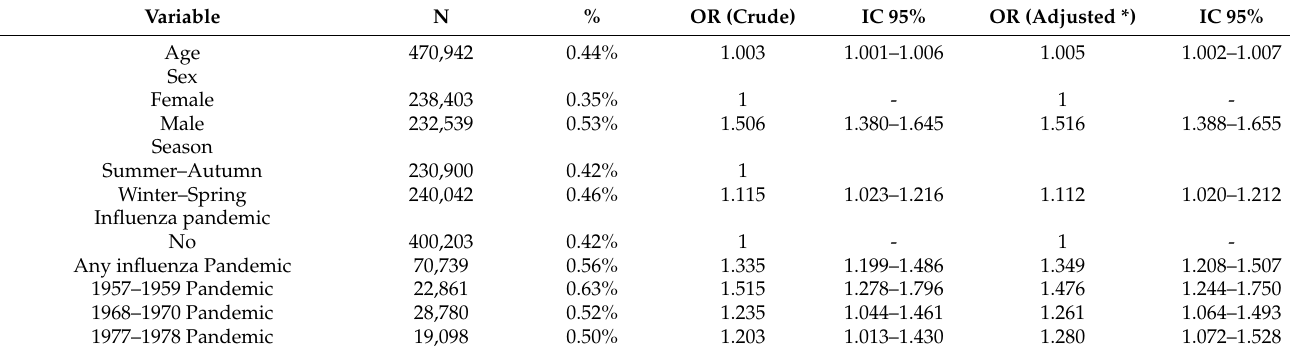
Table 3. Prevalence odds ratio of schizophrenia adjusted for sex, season of birth, and birth during an influenza